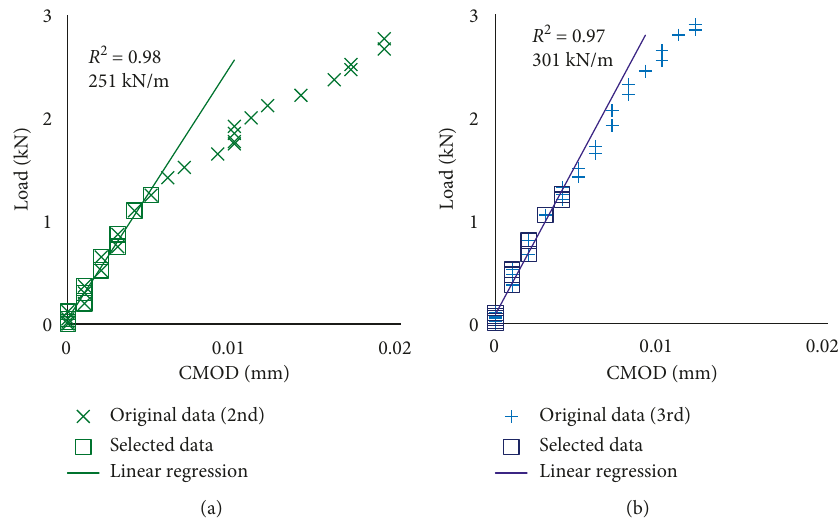
Figure 4: Example of the initial slope of the load-CMOD curve of (a) the 2nd loading and (b) the 3rd loading